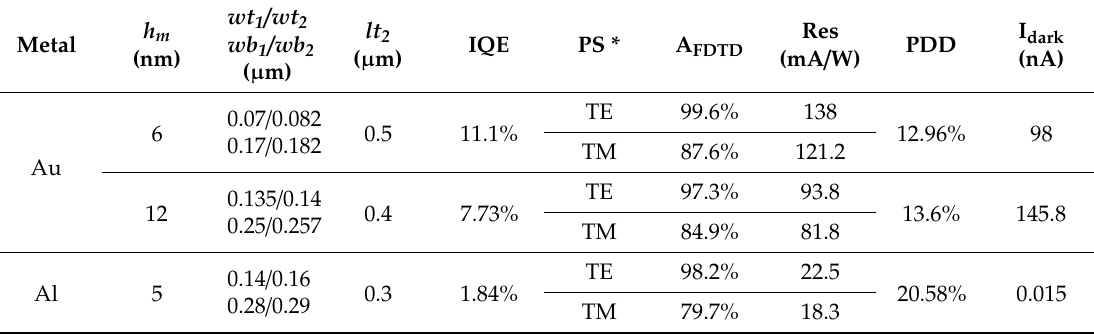
Table 1. Structure parameters of the dual-layer metal configuration and absorption rate at 1.55 µ m simulated by FDTD under di ff erent metal types and thicknesses.